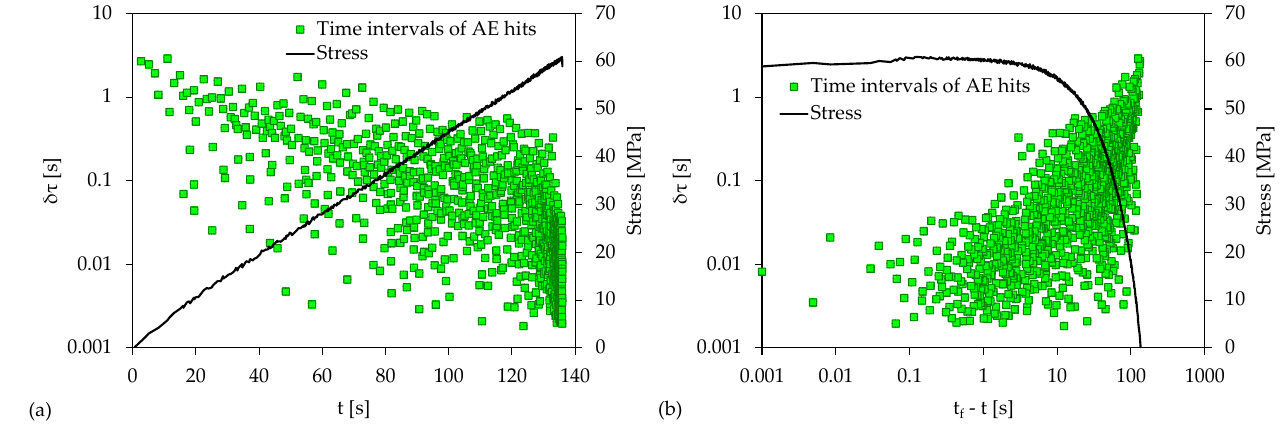
Figure 4. The temporal evolution of the AE time intervals ( δτ ) in juxtaposition with the stress applied, ( a ) using a conventional time-scale, ( b ) using the UC loading protocol.